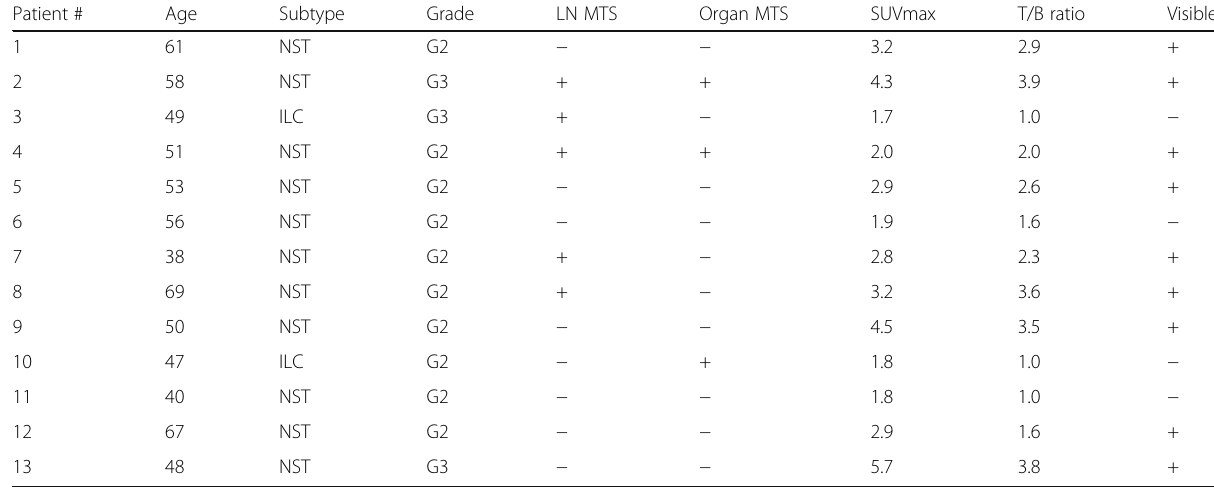
Table 1 CXCR4-targeted PET imaging with 68 Ga-Pentixafor of primary breast cancer patients with corresponding age, tumor subtype, tumor grade (G), presence of lymph node (LN) metastases, or organ metastases, SUVmax of the primary tumor, and tumor-to- background (T/B) ratio